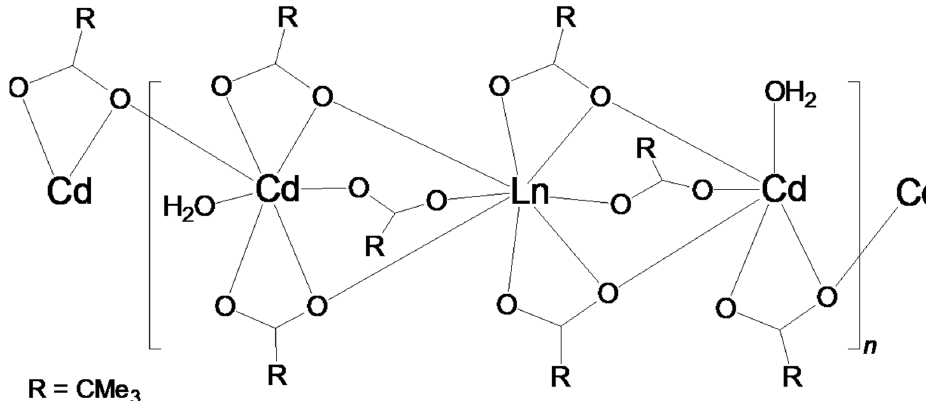
Scheme 1. Schematic structure of 1 – 7 .